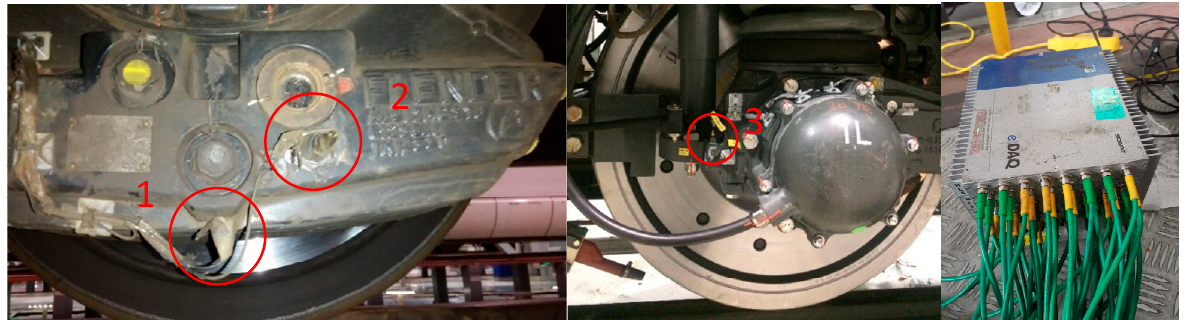
Figure 6. Measuring points of gearbox and axle box.